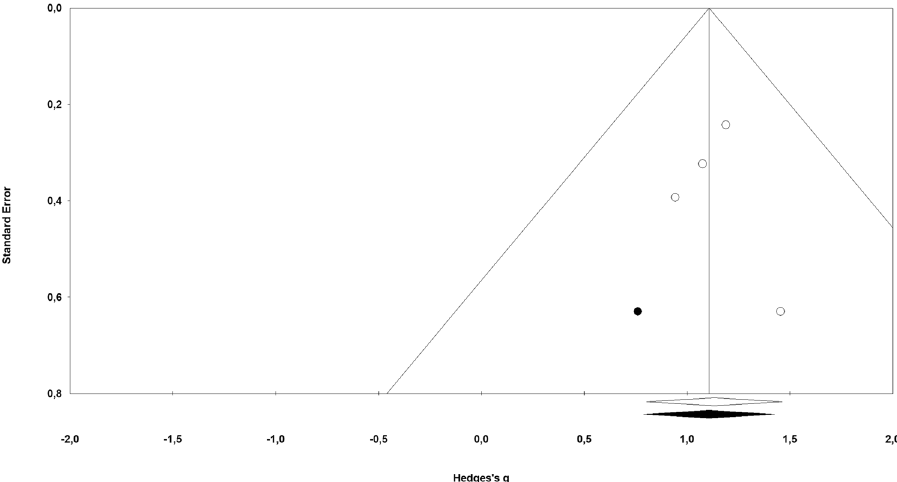
Fig. 3 Funnel plot of precision of standard error by Hedges ’ s g for publication